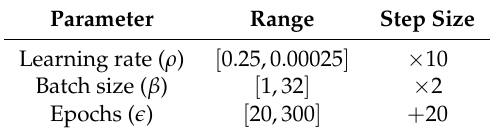
Table 1. Ranges and step sizes for the hyper-parameter